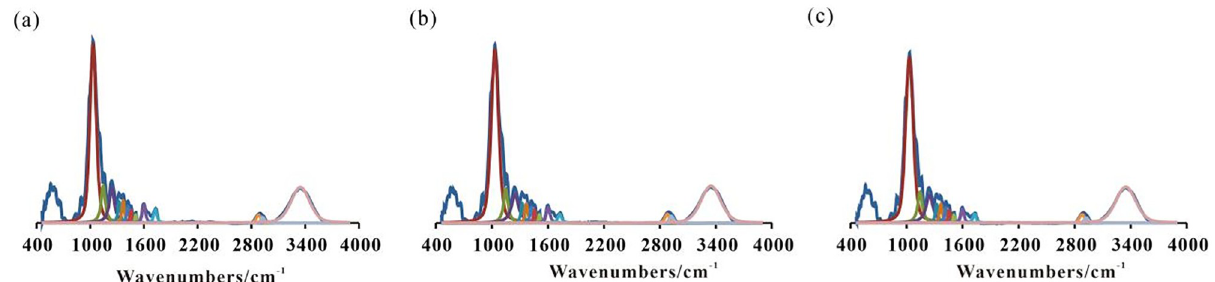
Fig 5. FTIR fitting of different functional groups in G0 (a), G1 (b) and G2 (c).